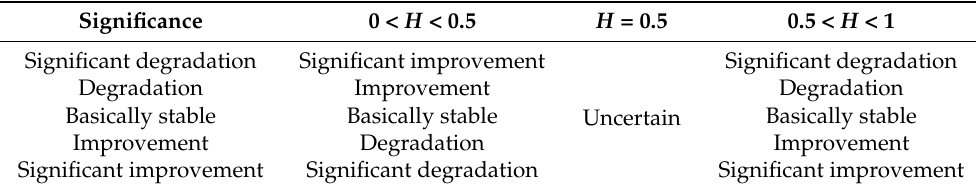
Table 2. Classification of sustainability in EVI